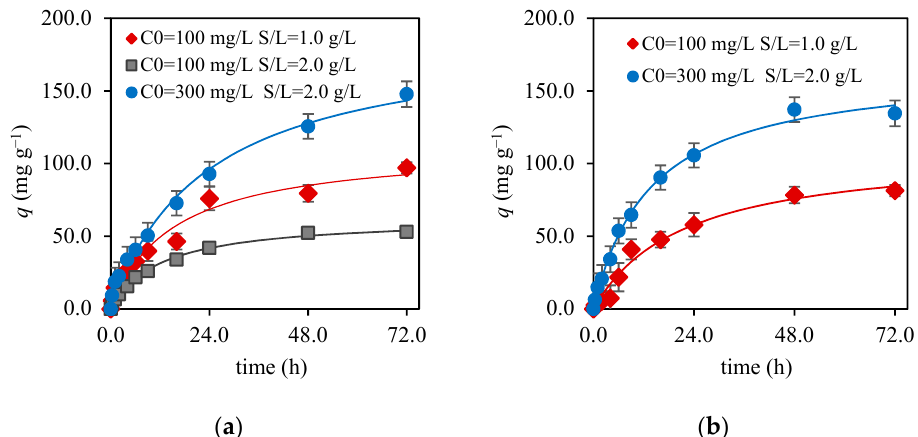
Figure 3. Effect of contact time on the uptake of gold by the pine bark tannin resin at 20 °C, different initial gold concentrations, adsorbent dosages and using aqueous solutions of ( a ) 1.0 mol L − 1 HCl ( a ) and ( b ) aqua regia 1.0 mol L − 1 H + : experimental data and pseudo-second order modelling.